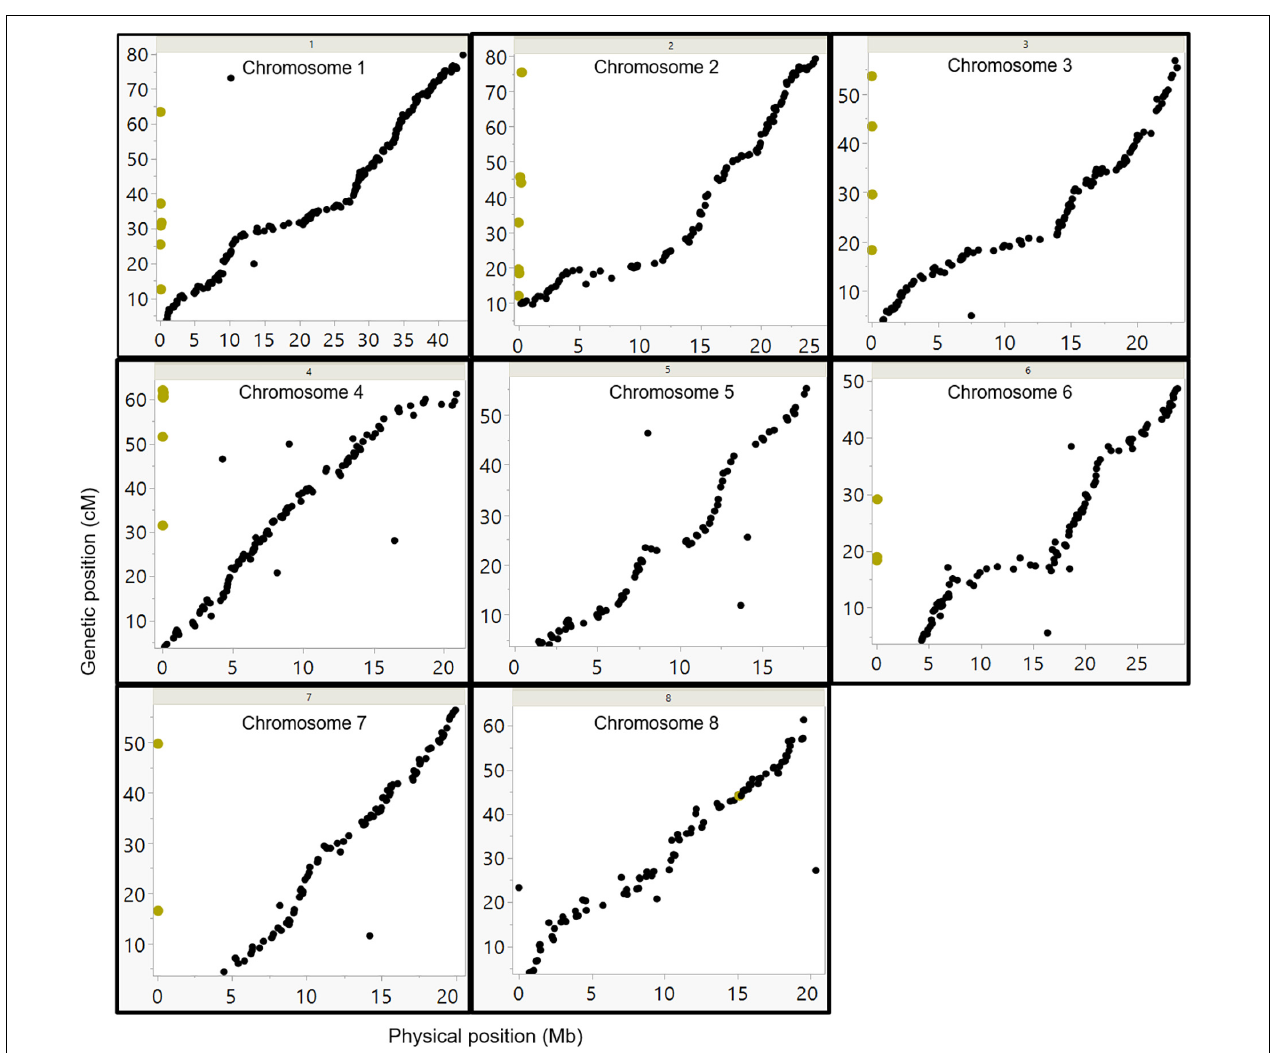
FIGURE 5 | Comparison between the genetic and physical order of the markers. SNP markers were placed according to their physical position on the Lauranne reference genome sequence ( x -axis), and their position on the U.E.F. genetic map ( y -axes). The yellow dots represent the markers from unplaced scaffolds, according to the Lauranne reference genome (chr-0). Those markers were mapped to several chromosomes in this study based on the genetic map